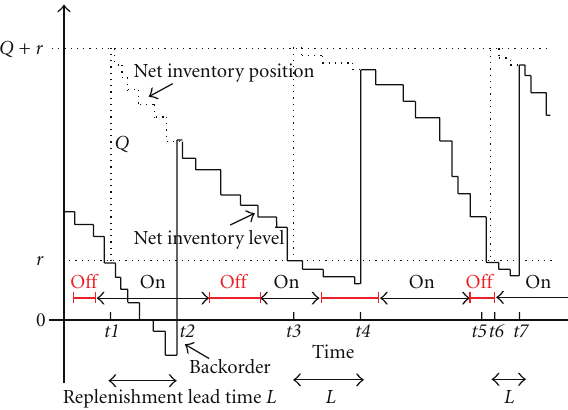
Figure 2: A ( Q , r ) inventory policy with supply